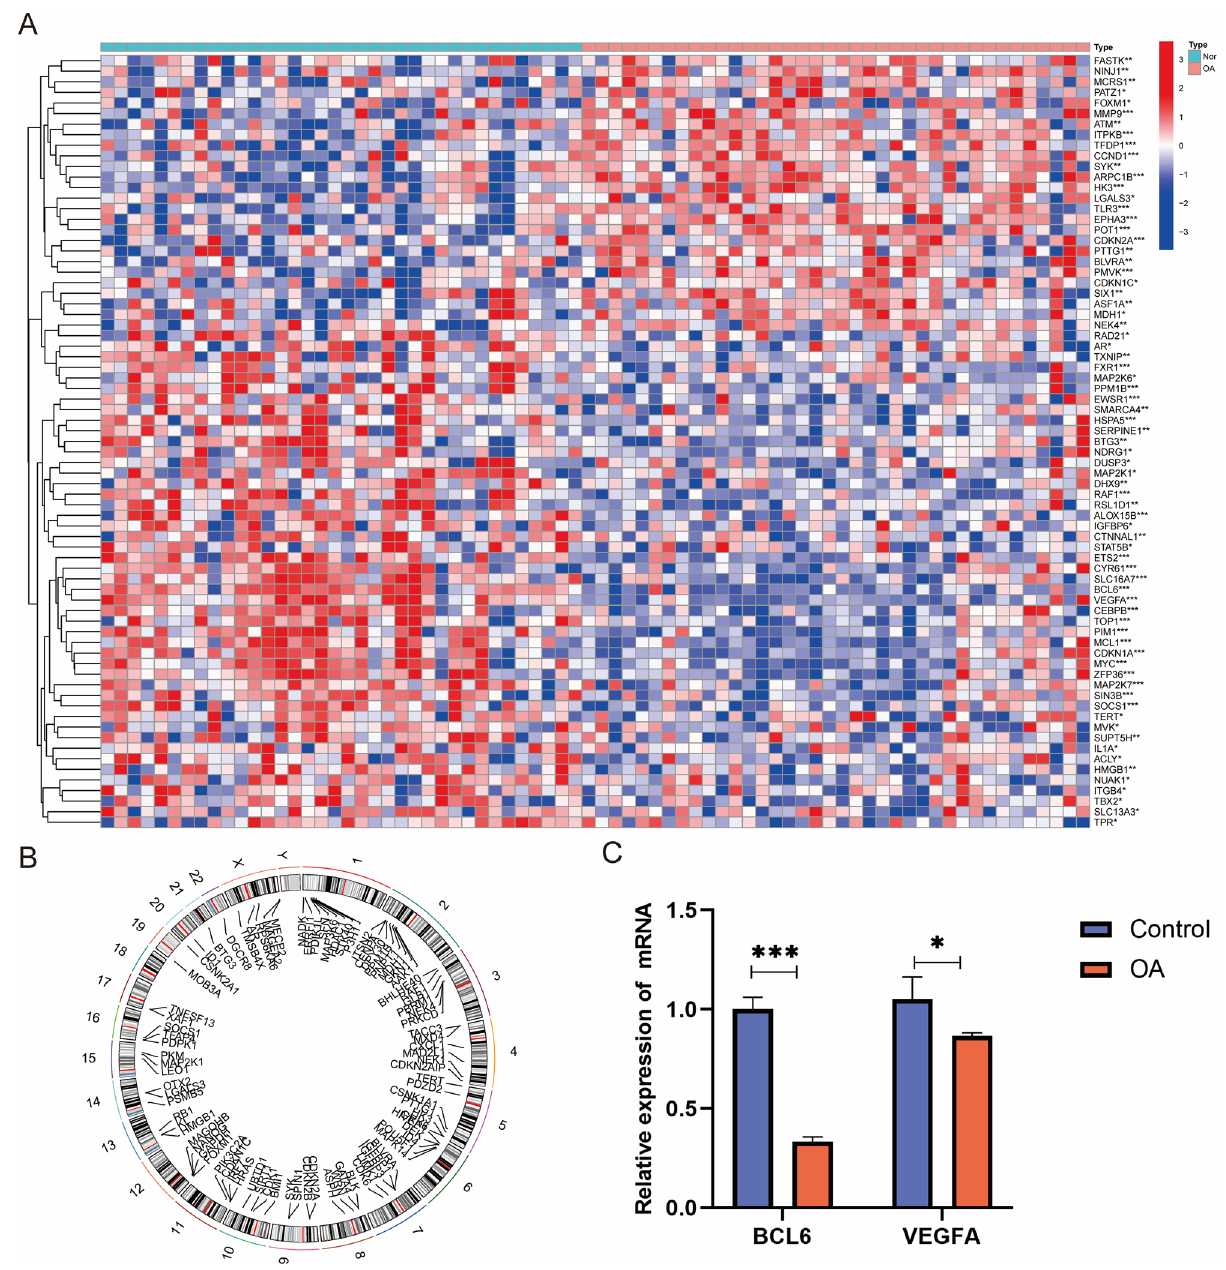
Figure 1. Identification of differentially expressed senescence genes in OA. ( A ) Heatmap showing the significantly different expression of senescence regulator genes in OA and normal synovial tissues. ( B ) The location of these genes on the chromosome. ( C ) The relative expression of mRNA in the normal and OA group. (All figures *represents p < 0.05, **represents p < 0.01, ***represents p < 0.001) OA,